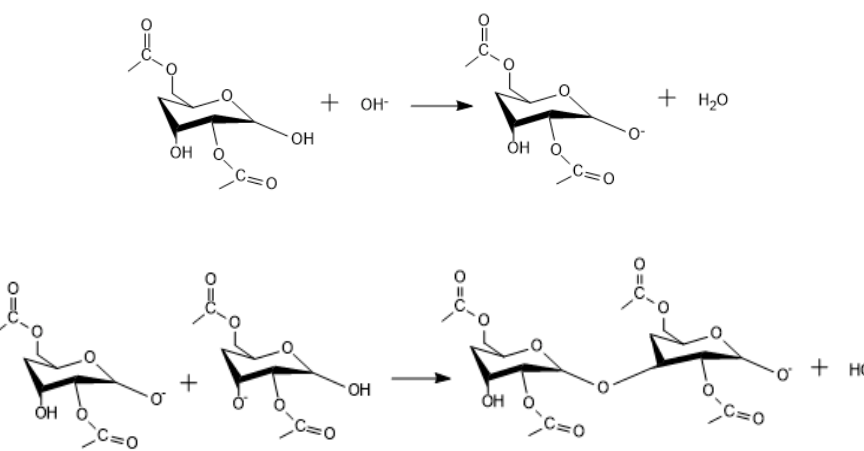
Figure A5. Two step homo-condensation: between CA–CA polymer molecules.